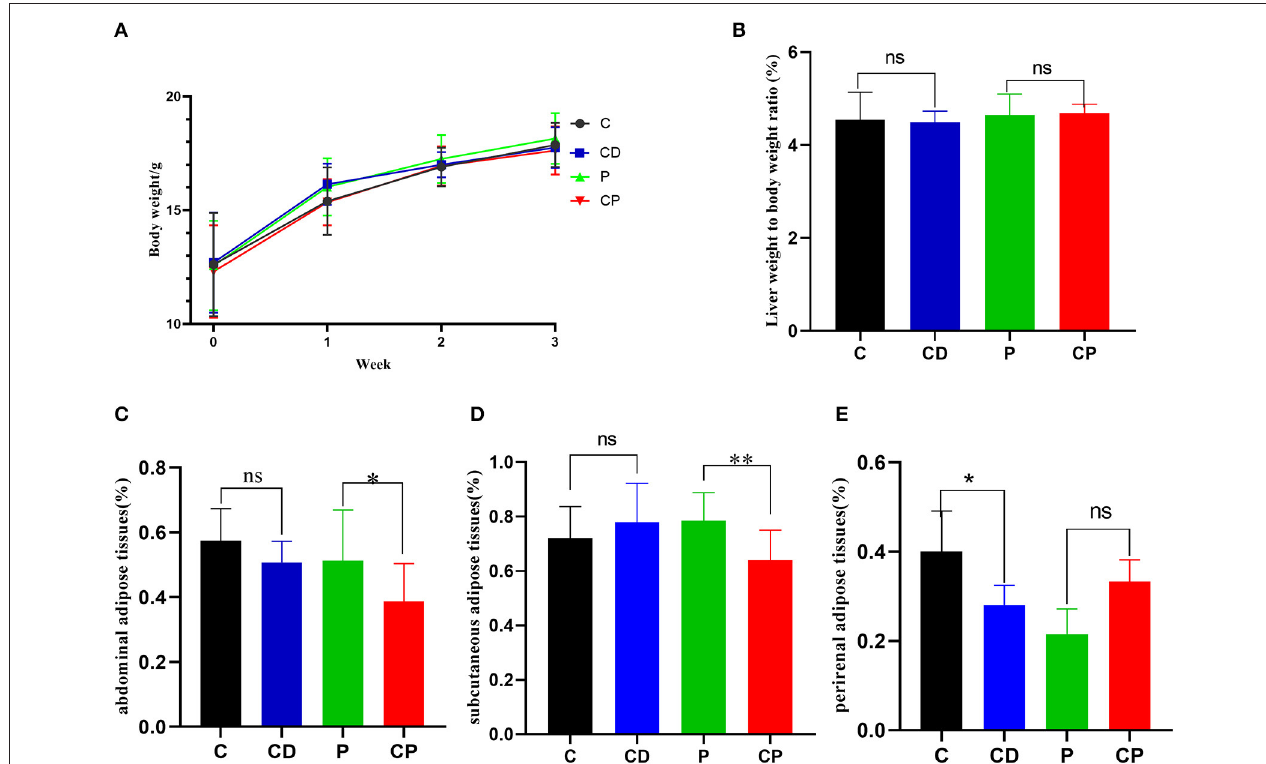
FIGURE 1 | Chenpi alleviated the accumulation of adipose in mice ( n = 9–10). (A) The body weight in 3 weeks (g); (B) the relative weight of liver to body weight; (C) abdominal adipose tissues to body weight ratio (%); (D) subcutaneous adipose tissues to body weight ratio (%); and (E) perirenal adipose tissues to body weight ratio (%). * P < 0.05; ** P < 0.01; and ns P >